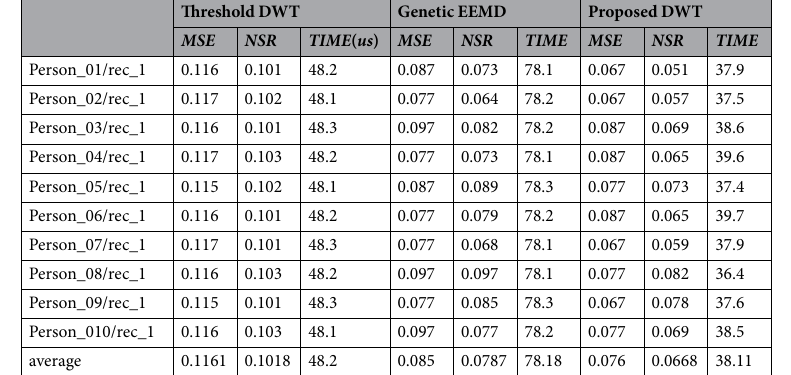
Table 3. Comparison of the effect of three different denoising algorithms.